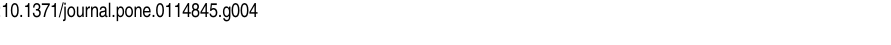
Fig. 4. Emulsion power of different sugar esters at a concentration of 0.02% (w/v) in soybean oil–water system. Different letters represent significant difference ( p , 0.05).